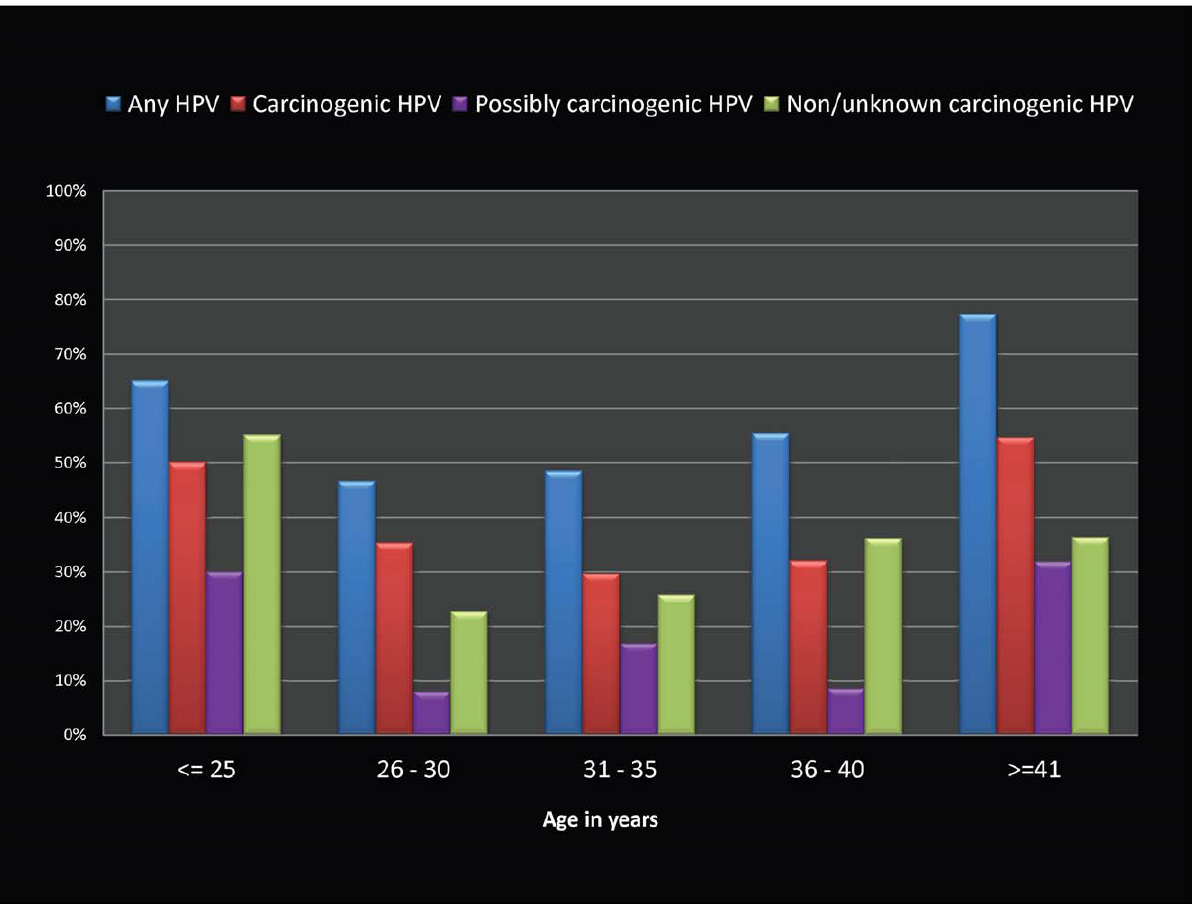
Figure 1. Bar graphs showing HPV genotype prevalence by age categories among HIV-infected women in Pune, India. HPV prevalence levels (as percentages) are displayed on the Y-axis, with various carcinogenicity groupings (any HPV type, carcinogenic HPV type, possibly carcinogenic HPV types, and non/unknown carcinogenic types) shown as individual bar graphs grouped by age categories ( # 25, 26–30, 31–35, 36– 40, & $ 41 years) on X-axis.